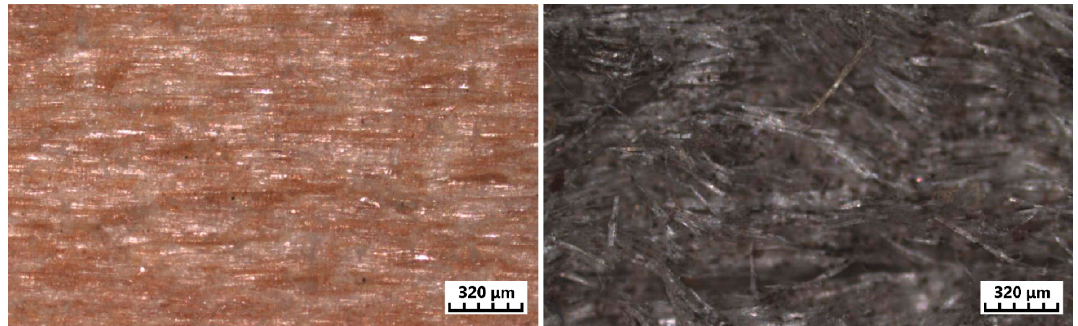
Figure 11. Confocal laser scanning microscopy of alder wood before and after 2 years of weathering (detail).